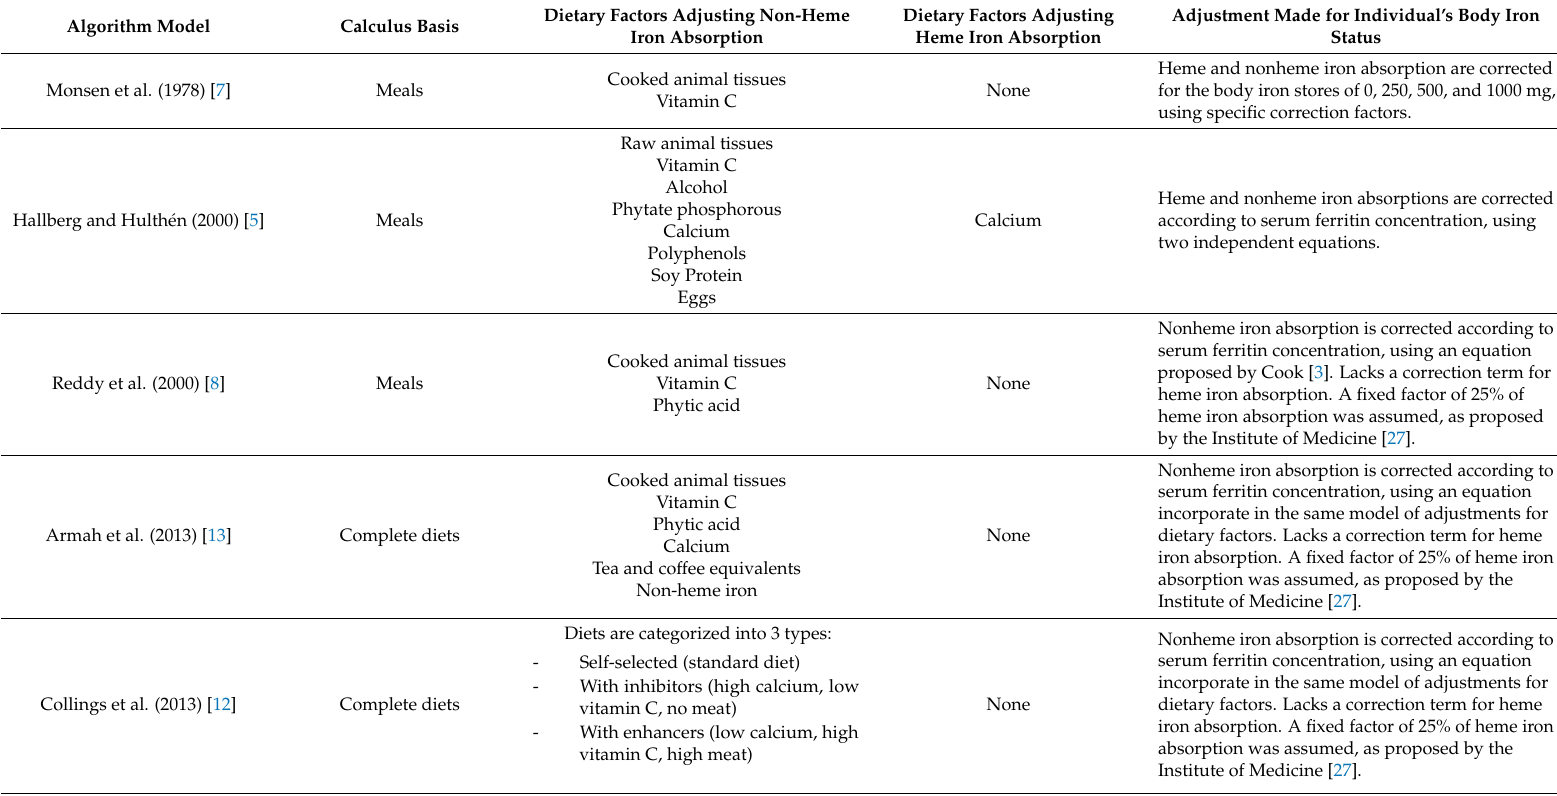
Table 1. Summary characteristics of the five tested iron bioavailability